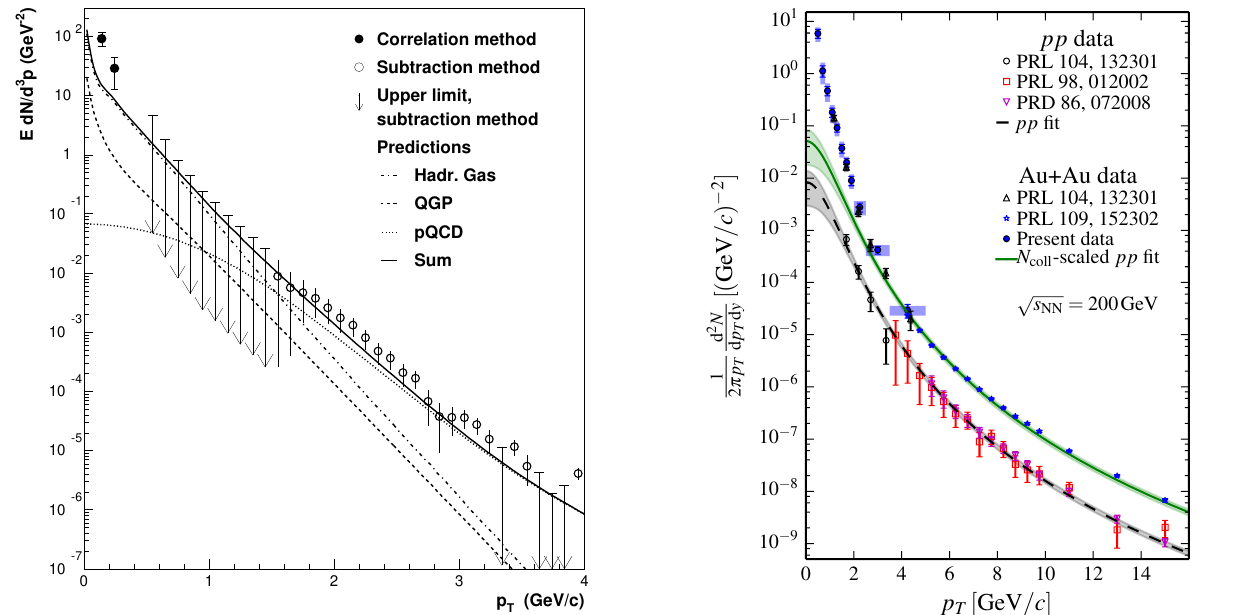
Figure 8. Left plot: direct photon spectrum in 0-20% central 158 A GeV 208 Pb+ 208 Pb collisions extracted with two methods: from the strength of the two-photon correlation (closed circles) and by the statistical method (open circles, or arrows indicating upper limits) [13]. Total statistical plus systematical errors are shown. Right plot: direct photon spectrum measured in pp and Au–Au collisions at √ s NN = 200 GeV with different methods, see